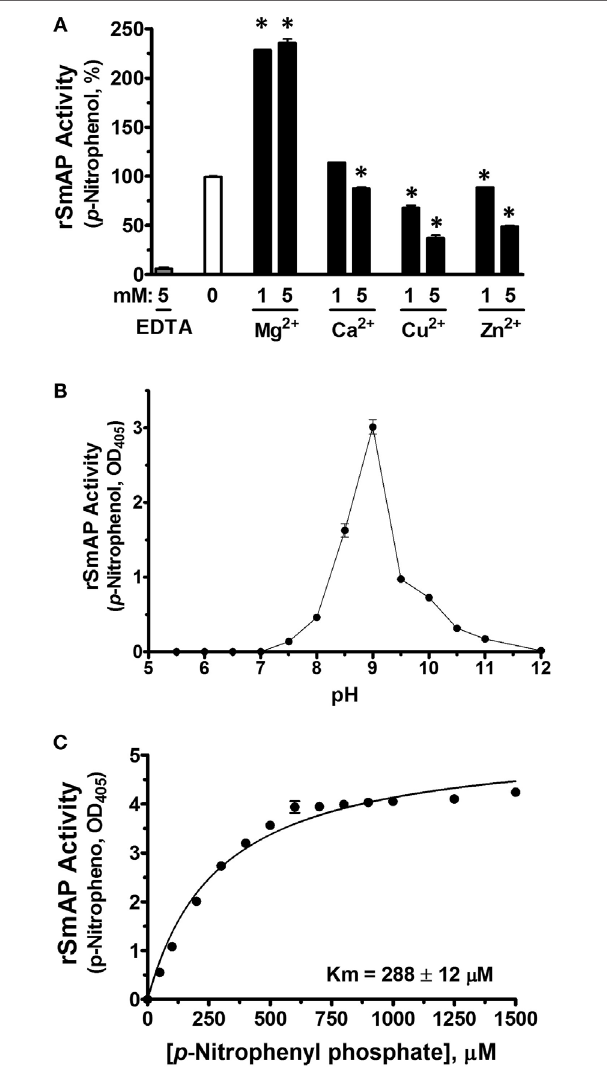
FigUre 3 | Characterization of rSmAP. (a) Relative activity of rSmAP ( p -NPP cleavage, mean OD 405 ± SD) in the presence of 0, 1, or 5 mM of added metal cations (Mg 2 + , Ca 2 + , Cu 2 + , or Zn 2 + ) or 5 mM ethylenediaminetetraacetic acid (EDTA), as indicated. Activity of rSmAP in buffer lacking added metal cations (0) is set at 100%. * indicates statistically significant difference compared to no additive (0; t -test, p < 0.05). (B) pH preference of rSmAP in the hydrolysis of p -NPP. (c) Michaelis–Menton plot of SmAP-mediated p -NPP cleavage kinetics; the Km of rSmAP for p -NPP is 288 ± 12 µM, derived from three independent